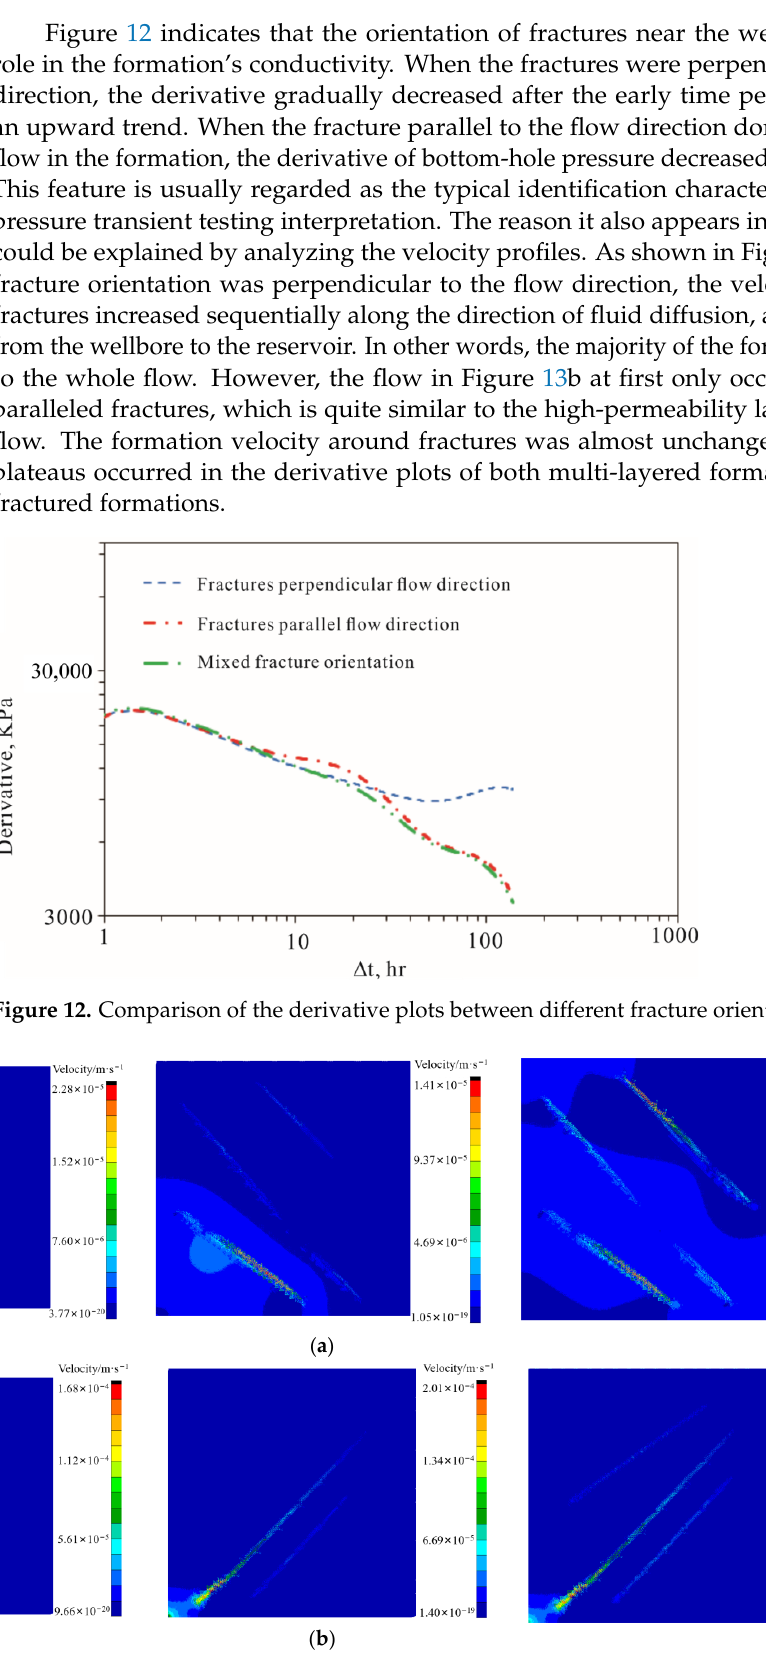
Figure 13. Velocity profiles changing with water injection. ( a ) Fractures perpendicular to the flow direction; ( b ) Fractures parallel to the flow direction.